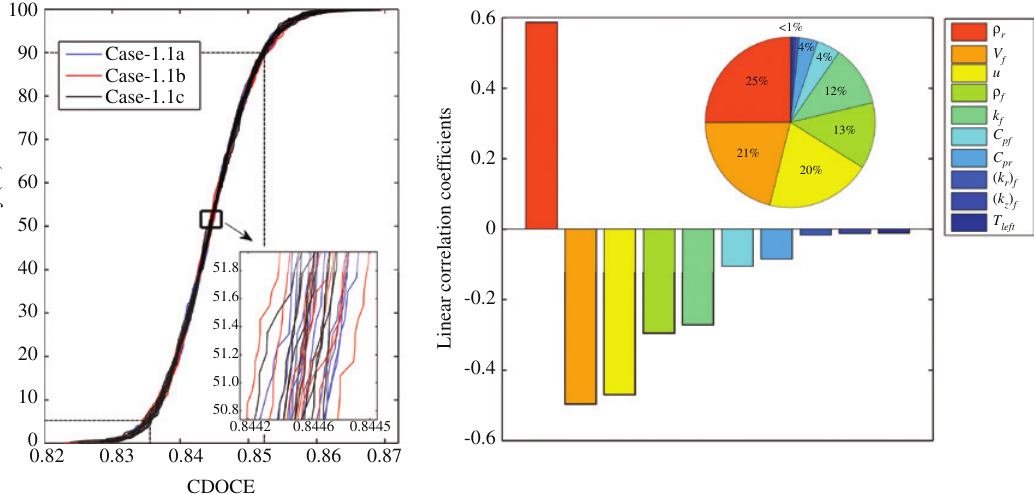
Figure 4 CDFs of each option in case 1 for 10 separate runs (left). The linear correlation coefficients (mean values of the three options in case 1.1 for 10 runs) between the RIPs and the CDOCE are shown in the bar plot, and the corresponding sensitivities are shown in the pie chart (right).